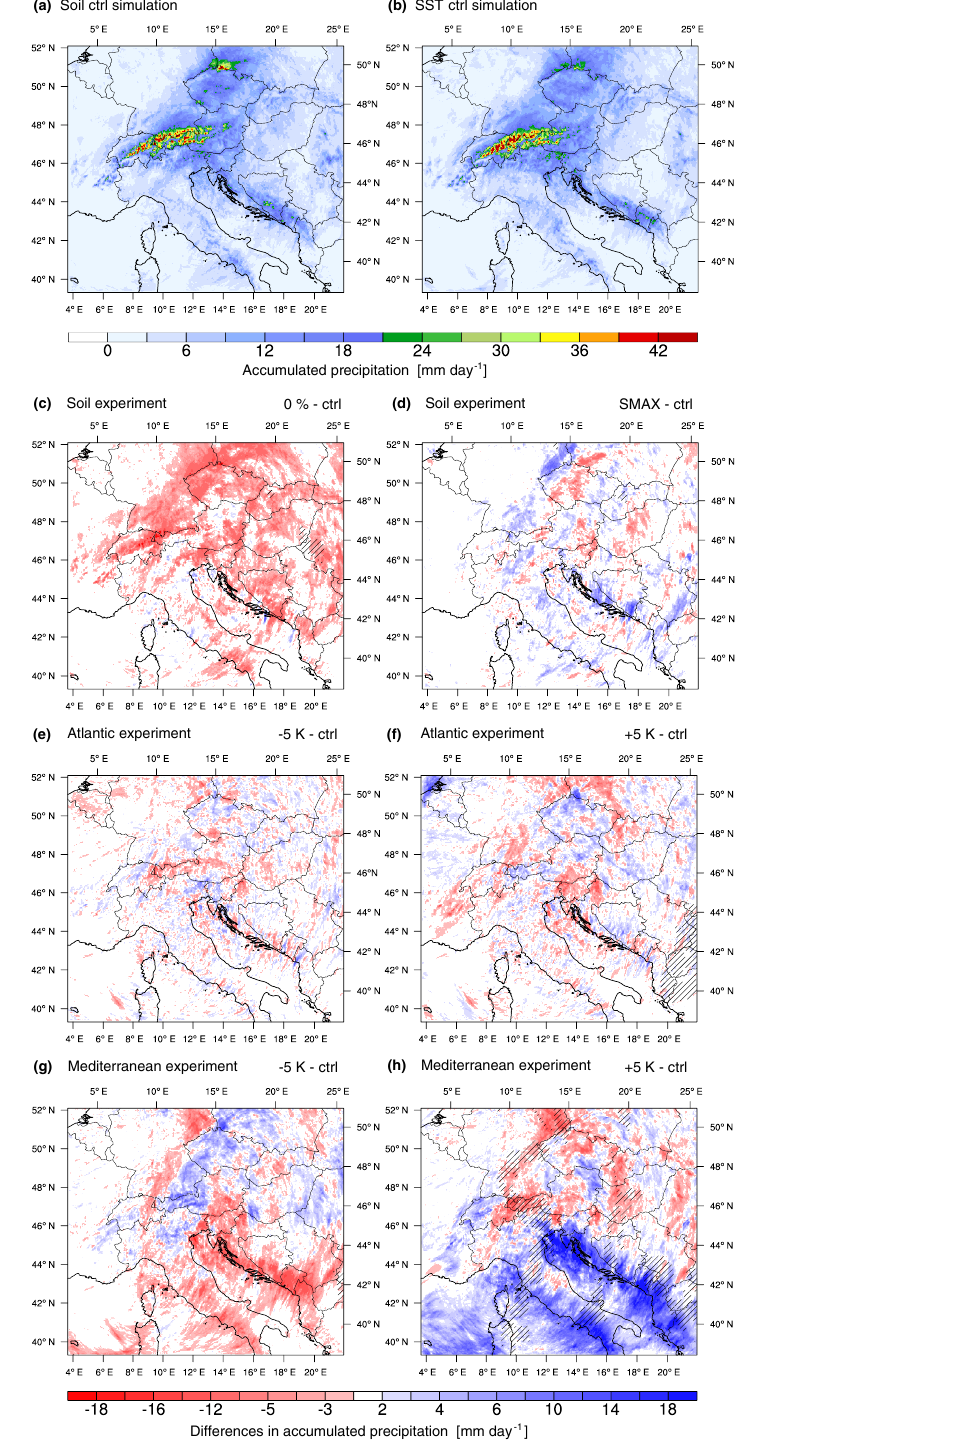
Figure 5. Panel (a) shows the accumulated precipitation (mmday − 1 ) for the control simulation of the soil moisture experiments averaged over the five Vb events. Panel (b) shows the same as panel (a) but for the SST experiments. The second to fourth rows show the differ- ences between the mean daily precipitation obtained by the different sensitivity experiments and the control simulation (mmday − 1 ). Panel (c) shows the complete drainage soil experiment, panel (d) the full saturation soil experiment, panels (e) and (f) the − 5 and + 5K Atlantic SST experiments, respectively, and panels (g) and (h) the − 5 and + 5K Mediterranean SST experiments. The hatched area denotes significant changes at the 5% significance level using a non-parametric Mann–Whitney U